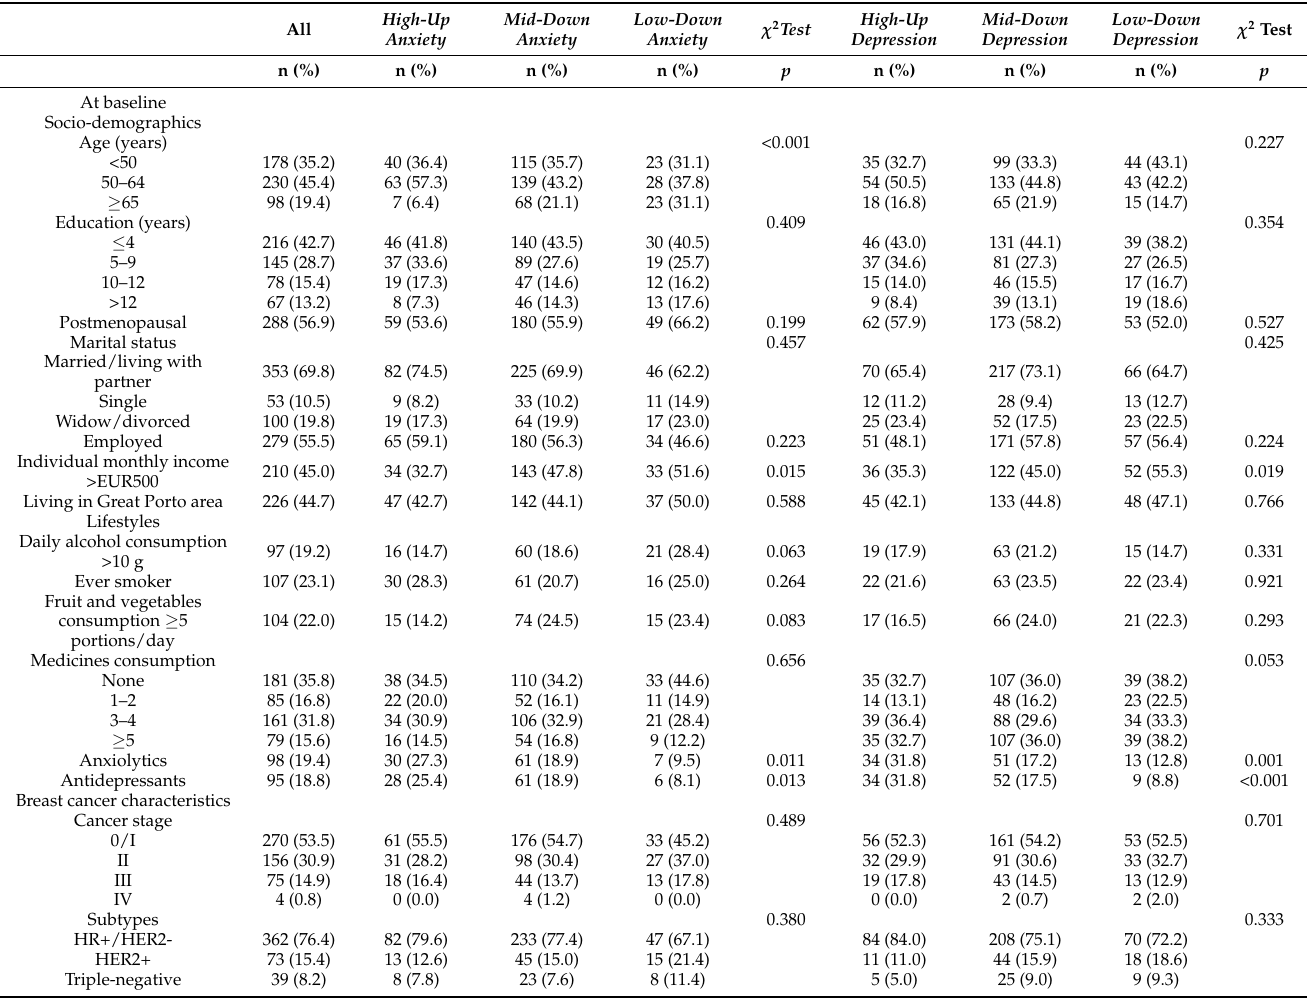
Table 1. Sociodemographic characteristics of participants, lifestyles, medicines consumption, breast tumor characteristics, and treatments, according to anxiety and depression